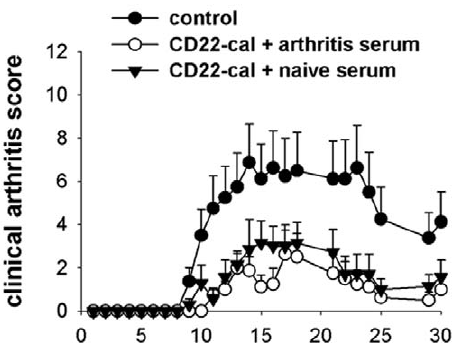
Figure 5. Serum transfer in CD22-cal treated mice. CD22-cal treated mice (day 2 6, day 2 1) or untreated mice were immunized with G6PI. At day 9 and 11, CD22-cal treated mice received 2 injections of pooled serum from either arthritic or naı¨ve SJL/J mice. Shown is the clinical arthritis score from all mice per group ( n =8 per group).